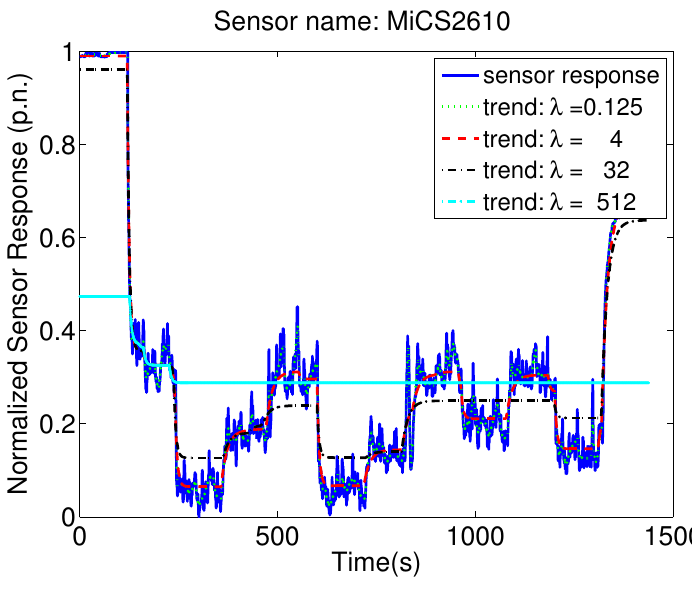
Figure 8. Estimated trends for the response of the MiCS 2610 for an experiment where the gas source was changing the emitted concentration. Corresponding regularization parameters for the illustrated trends are λ = 0 . 125 , λ = 4 , λ = 32 and λ = 512 .